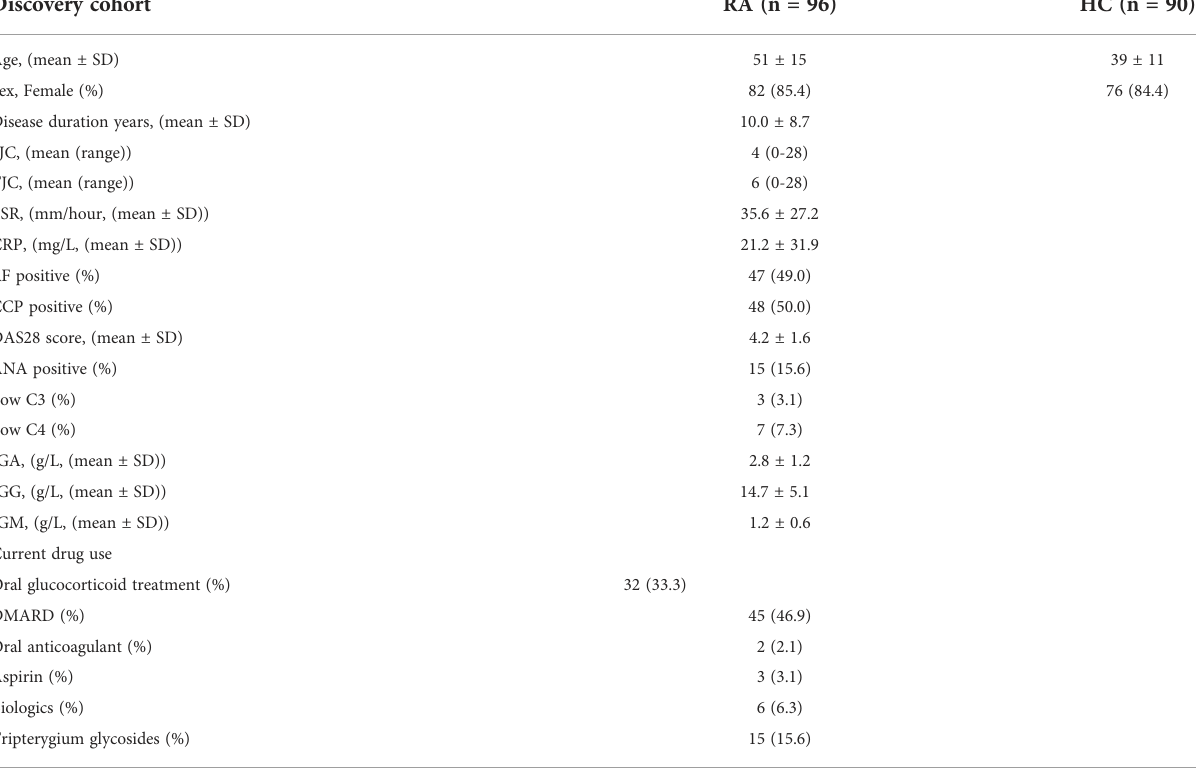
TABLE 2 Clinicopathologic characteristics of the RA patients and HC donors from discovery cohort. Discovery